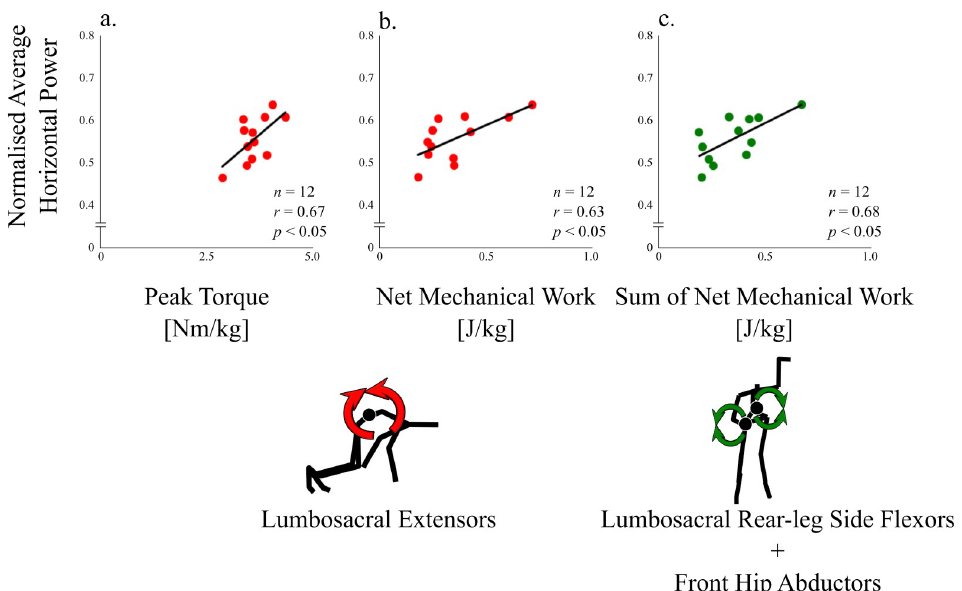
Fig 7. Relationships between lumbo-pelvic-hip variables [peak lumbosacral extension torque (a), net mechanical work exerted by lumbosacral extensors during double-stance phase (b), and sum of net mechanical work exerted by lumbosacral rear-leg side flexors and by front hip abductors during single-stance phase (c)] and starting performance (Normalised average horizontal power: NAHP).